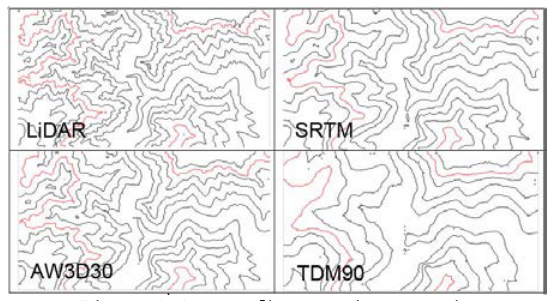
Figure 9. Contour lines test site Rolling, contour interval 10m